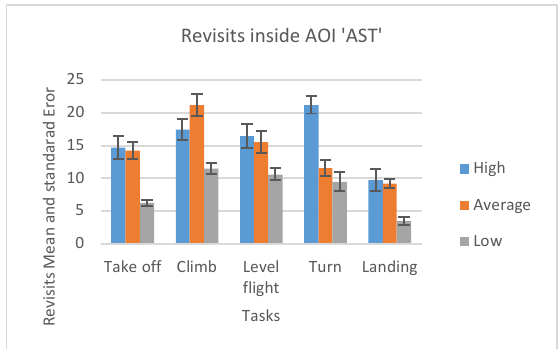
Figure 17. Number of revisits AOI ‘AST” for five flight phases for psychological selection stream with associ- ated Standard